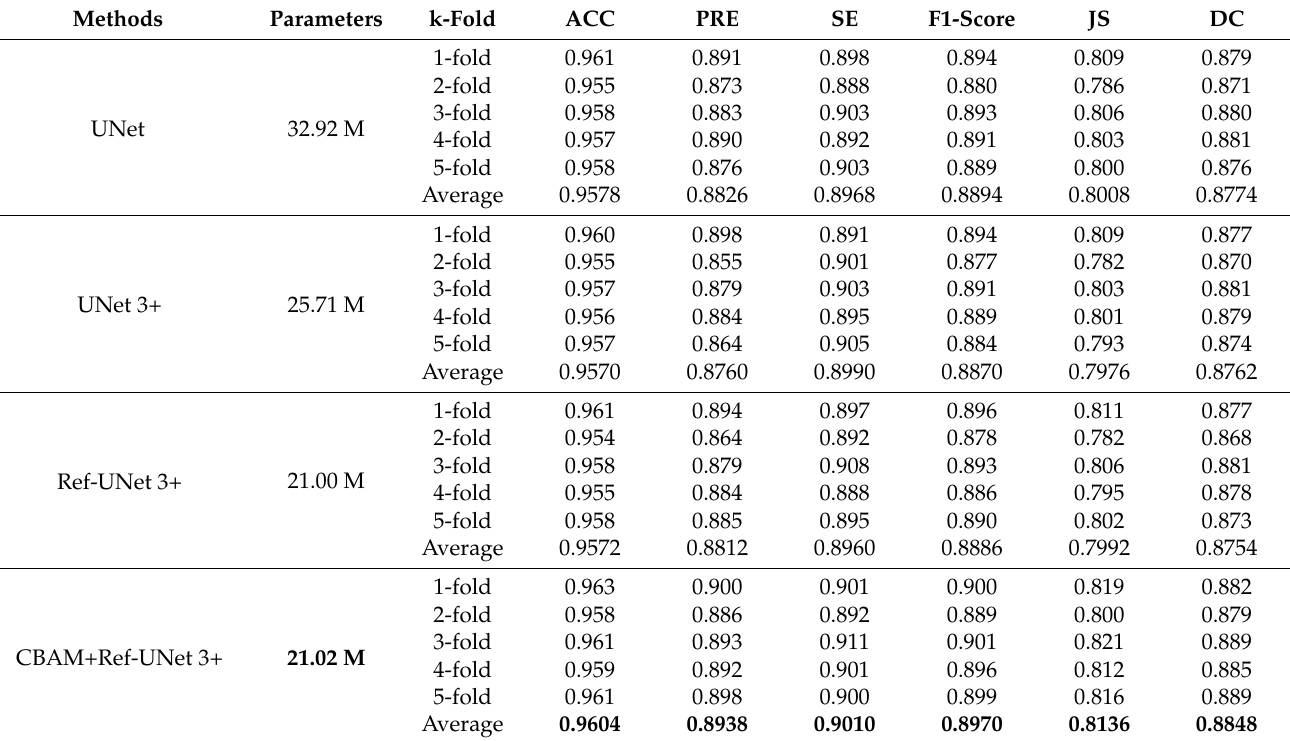
Table 1. Experimental results of proposed methods for skin cancer segmentation and comparison against other methods. The bold data denotes the best